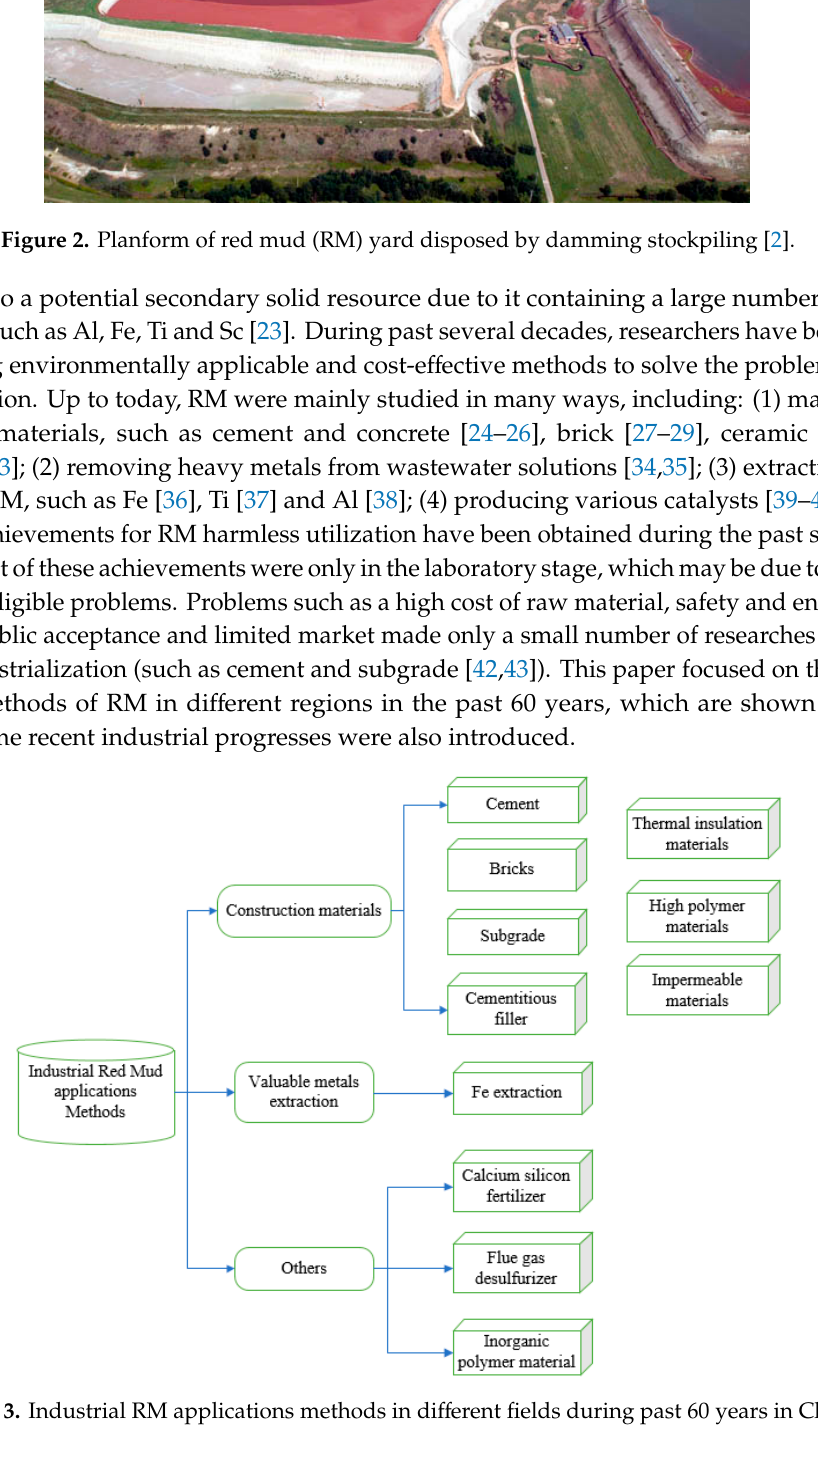
Figure 3. Industrial RM applications methods in different fields during past 60 years in China.